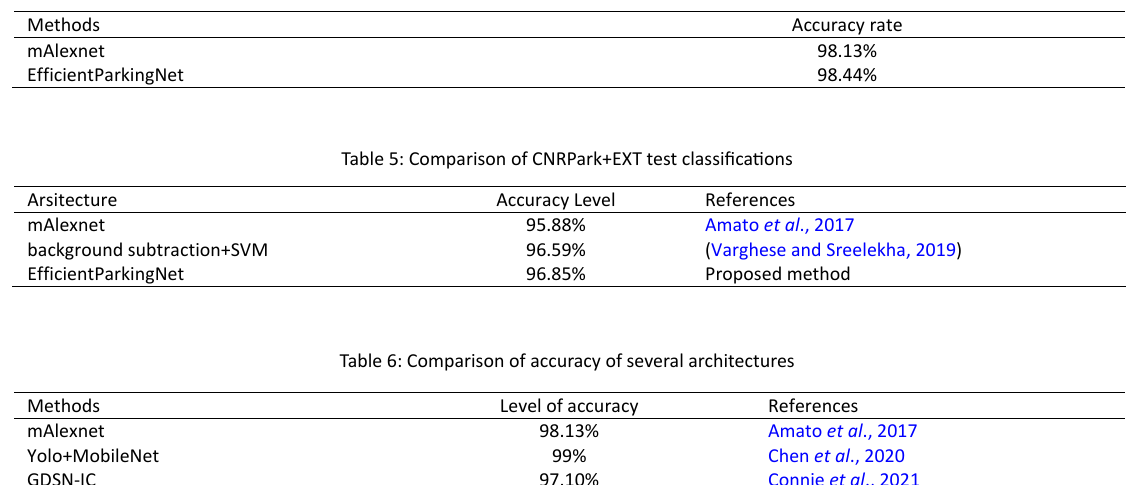
Table 4: Comparison of the accuracy level all data